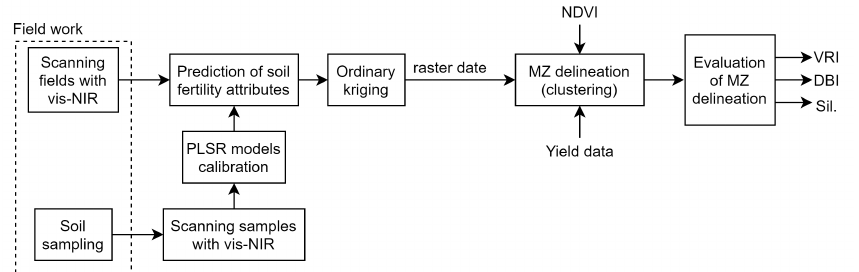
Figure 1. The flowchart of the evaluation steps different management zone (MZ) delineation schemes based on on-line collected soil fertility attributes, normalized difference vegetation index (NDVI), and yield. Different MZ delineation schemes were evaluated in terms of variance reduction index (VRI), Davies–Boulding index (DBI), and Silhouette index (Sil.). The soil fertility attributes were predicted based on visible-near-infrared (vis-NIR)